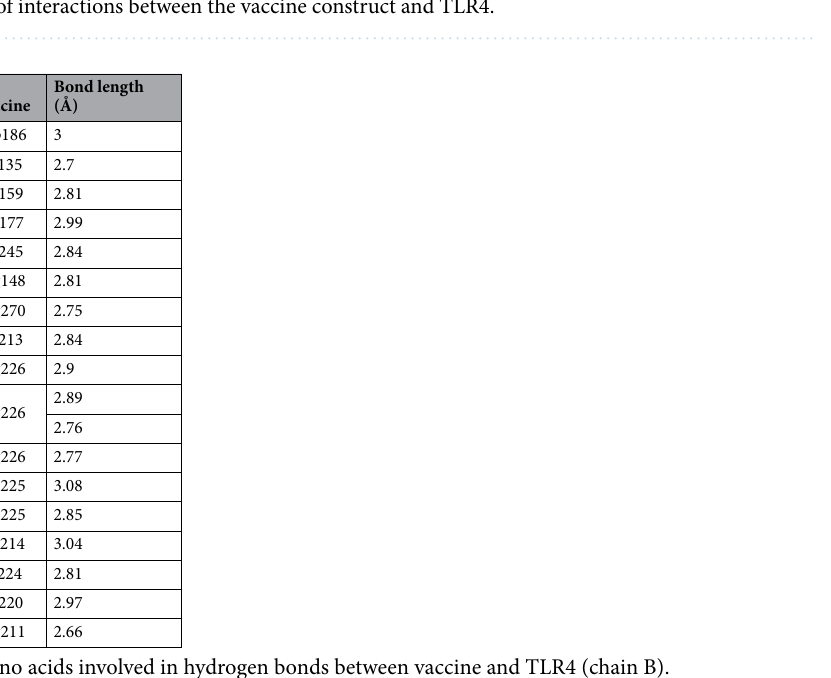
Figure 9. The map of interactions between the vaccine construct and TLR4.